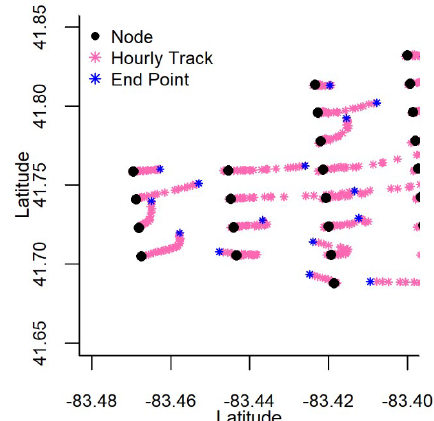
Figure B1. Surface current data were available hourly within west- ern Lake Erie. These 24h data were used to track the daily move- ment of water from each node.